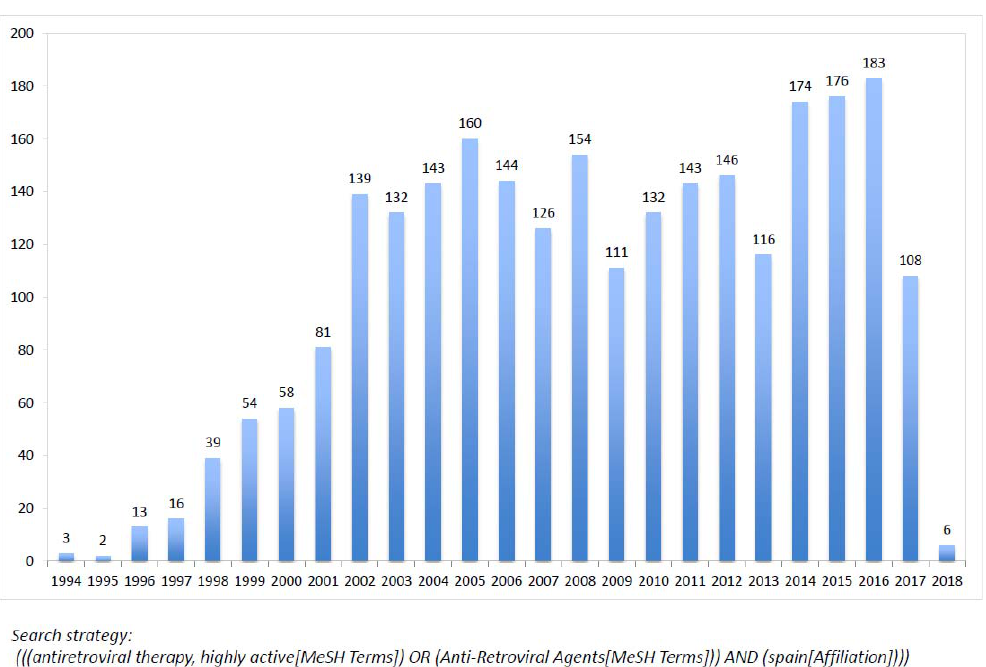
Figure 5. Major prospective clinical trials on antiretroviral Figure 4. Number of publications recorded yearly in PubMed on antiretroviral therapy by Spanish therapy in adults led by Spanish researchers. authors.